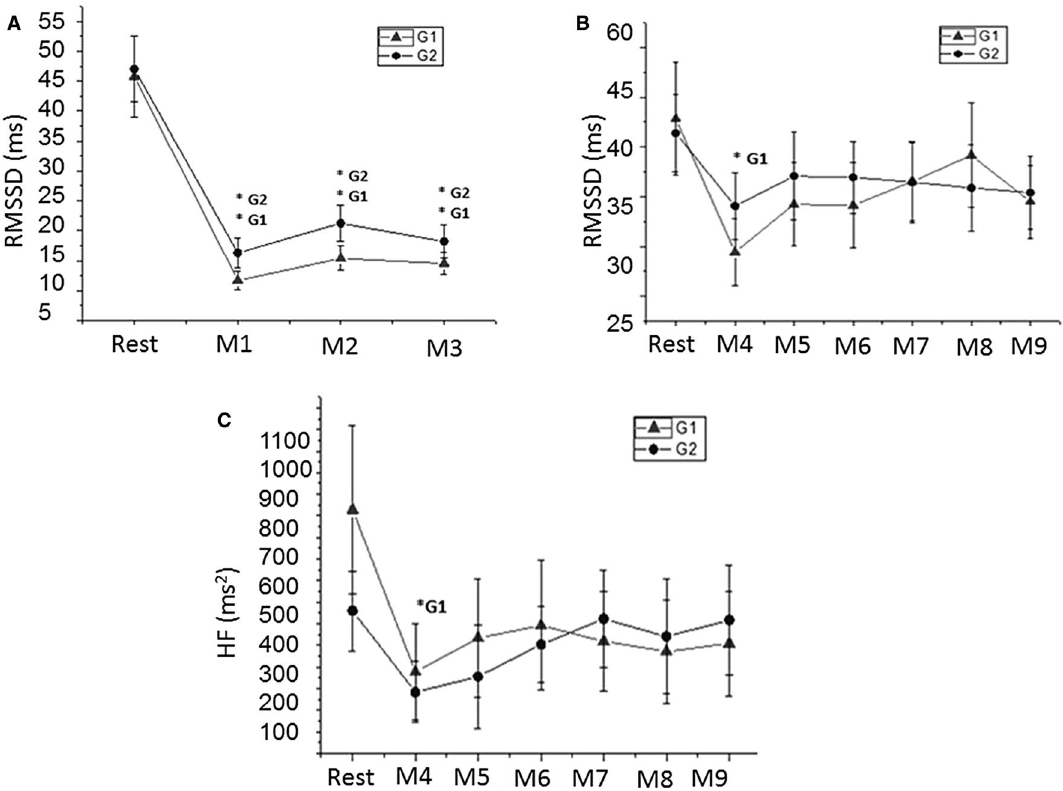
Figure 4. Mean values and respective standard deviations of ultra-short-term RMSSD ( A ), short term RMSSD ( B ) and short-term HF ( C ) obtained at rest and during recovery from moderate aerobic exercise protocol. *G1 and *G2: values with significant differences in relation to rest (p < 0.05) for G1 and G2, respectively. RMSSD square root of the square mean of the differences between adjacent normal IBI, HF high frequency, ms milliseconds, ms 2 absolute units, G1 birth weight between 2400 and 3200 g, G2 birth weight between 3200 and 4500 g, Rest 10th to 15th minute before exercise, M1 0 to 1 min, M2 1 to 2 min, M3 2 to 3 min, M4 5th to 10th minute, M5 15th to 20th minute, M6 25th to 30th minute, M7 35th to 40th minute, M8 45th to 50th minute and M9 55th to 60th during recovery from